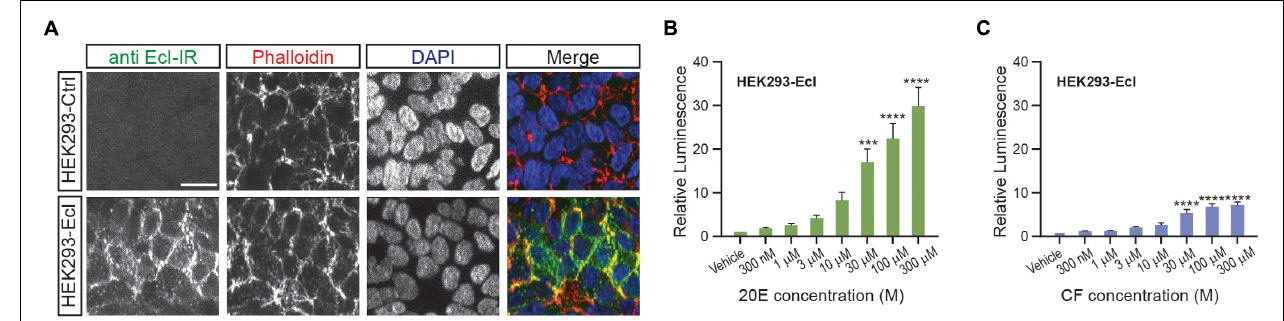
FIGURE 3 | Establishment of an EcI-expressing HEK293 cell line. (A) Immunocytochemistry of HEK293-Ctrl and -EcI cells using anti-EcI antibodies (green in merged images). Filamentous actin of the cytoskeleton and cell nuclei were stained with phalloidin (red in merged images) and DAPI (blue in merged images), respectively. Scale bar, 20 µ m. (B,C) Luciferase reporter activity in HEK293-EcI cells in response to different concentrations of 20E (B) or CF (C) . All values are the means ± S.E.M. [ n = 6 in panel (B) and 5 in panel (C) ]. One-way ANOVAs identified a significant effect of the 20E concentration [ F ( 7 , 40 ) = 21.23, p < 0.0001, (B)